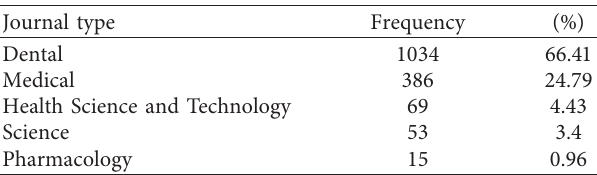
Table 5: Frequencies of Saudi dental publications among different journals.